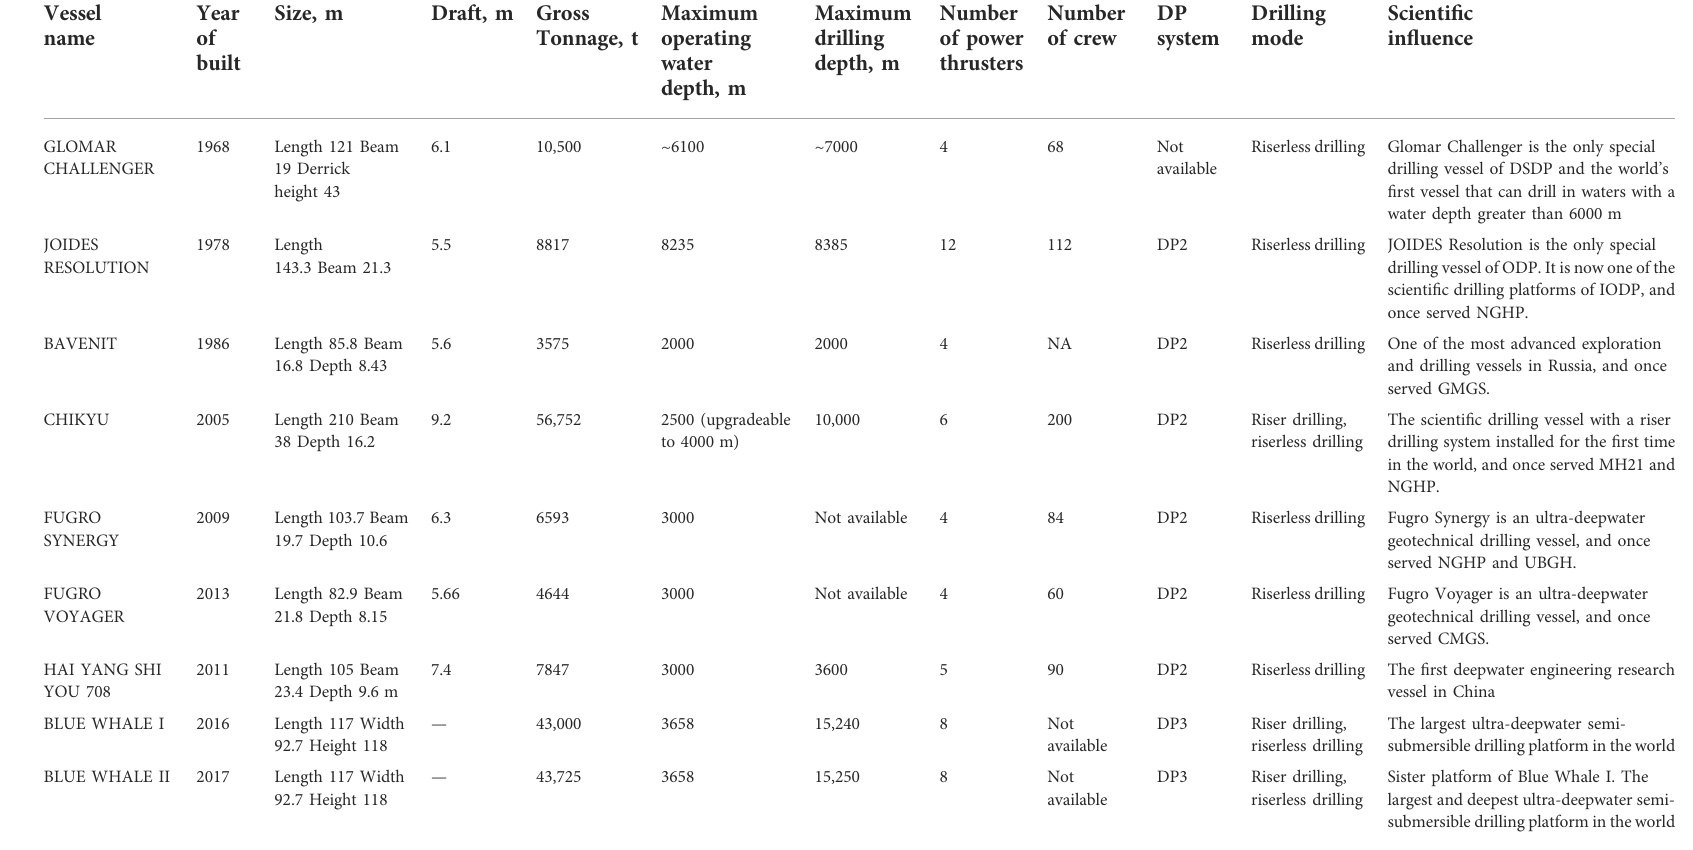
TABLE 5 Parameters of some drilling vessels (platforms) used for offshore gas hydrate